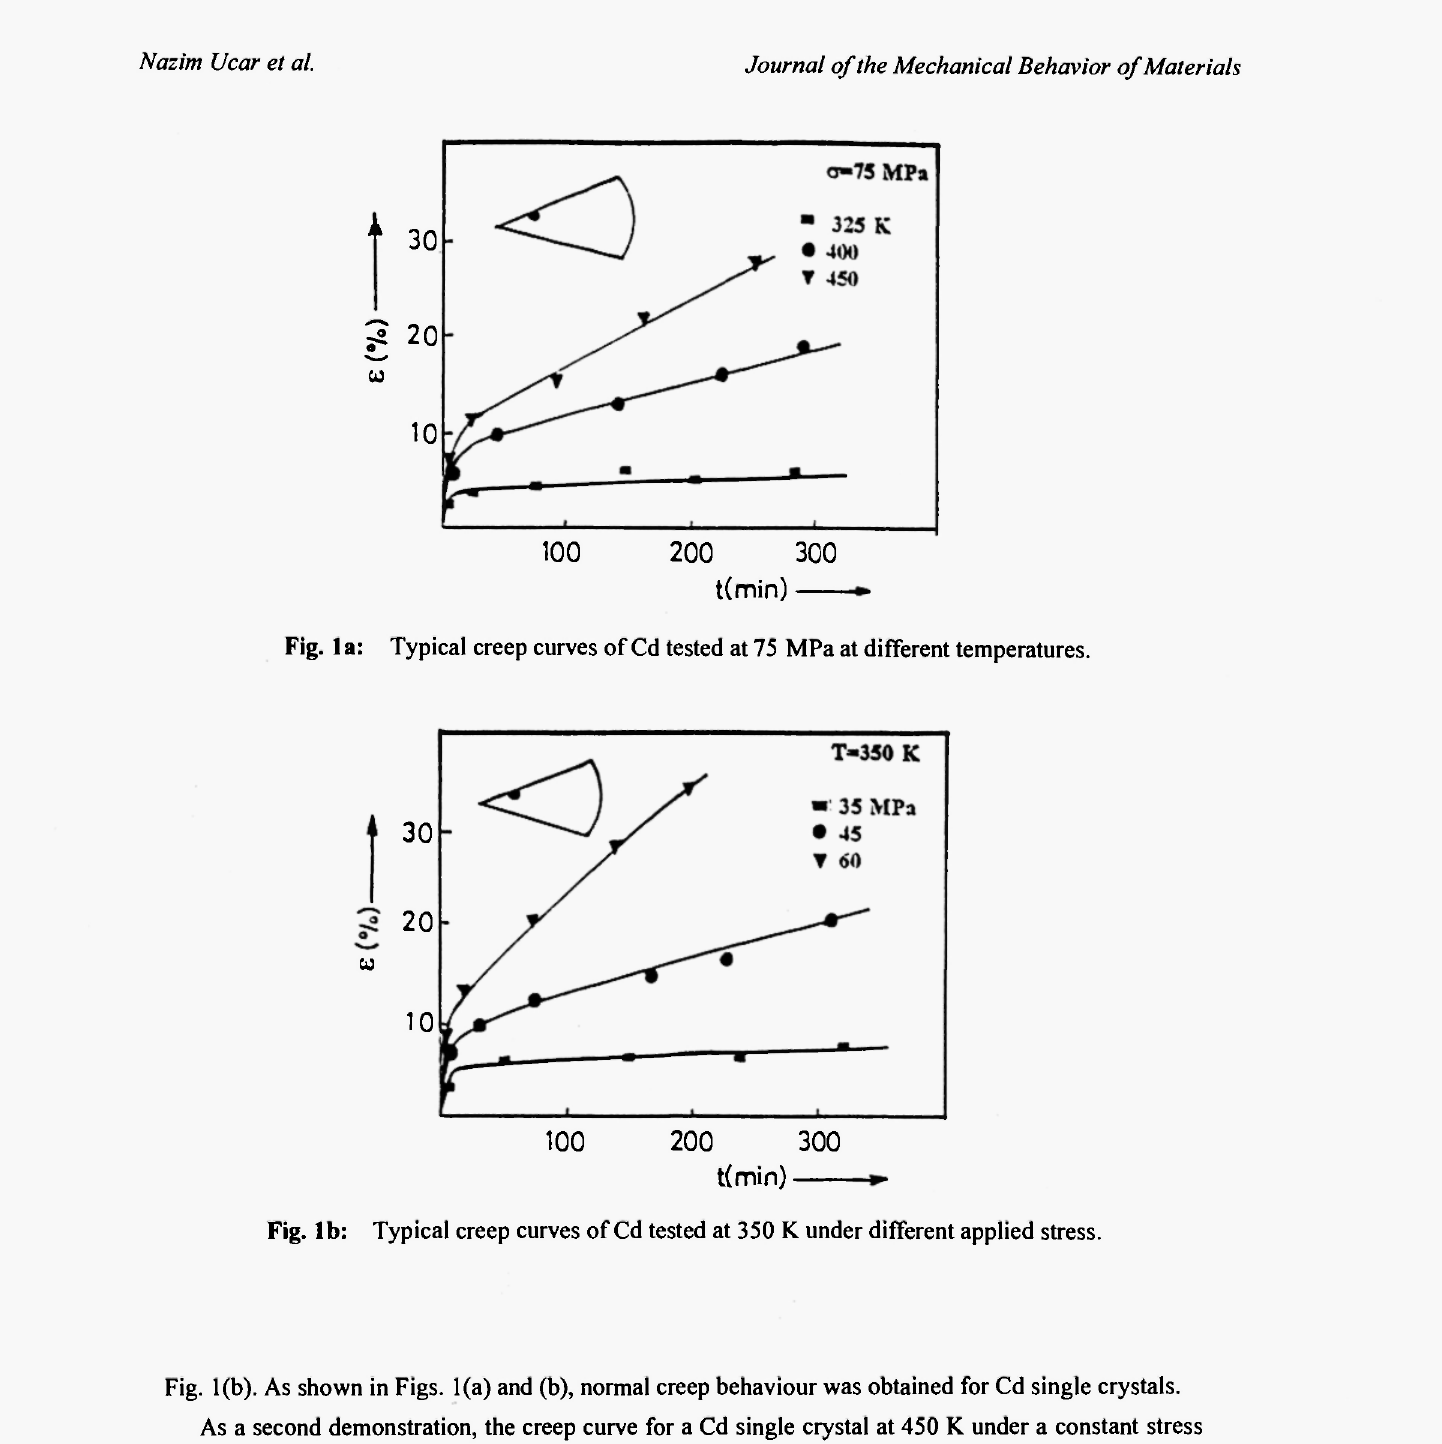
As a second demonstration, the creep curve for a Cd single crystal at 450 Κ under a constant stress of 75 MPa is shown in Fig. 2. Fig. 2 is a plot of the logarithm of creep rate versus strain. The creep curve resembles those observed for pure metals aand those non-metals which exhibit a normal primary creep period, during which the creep rate decreases with strain. After a steady-state period is reached, the creep rate remains essentially constant with strain. The steady-state creep rates were taken in this